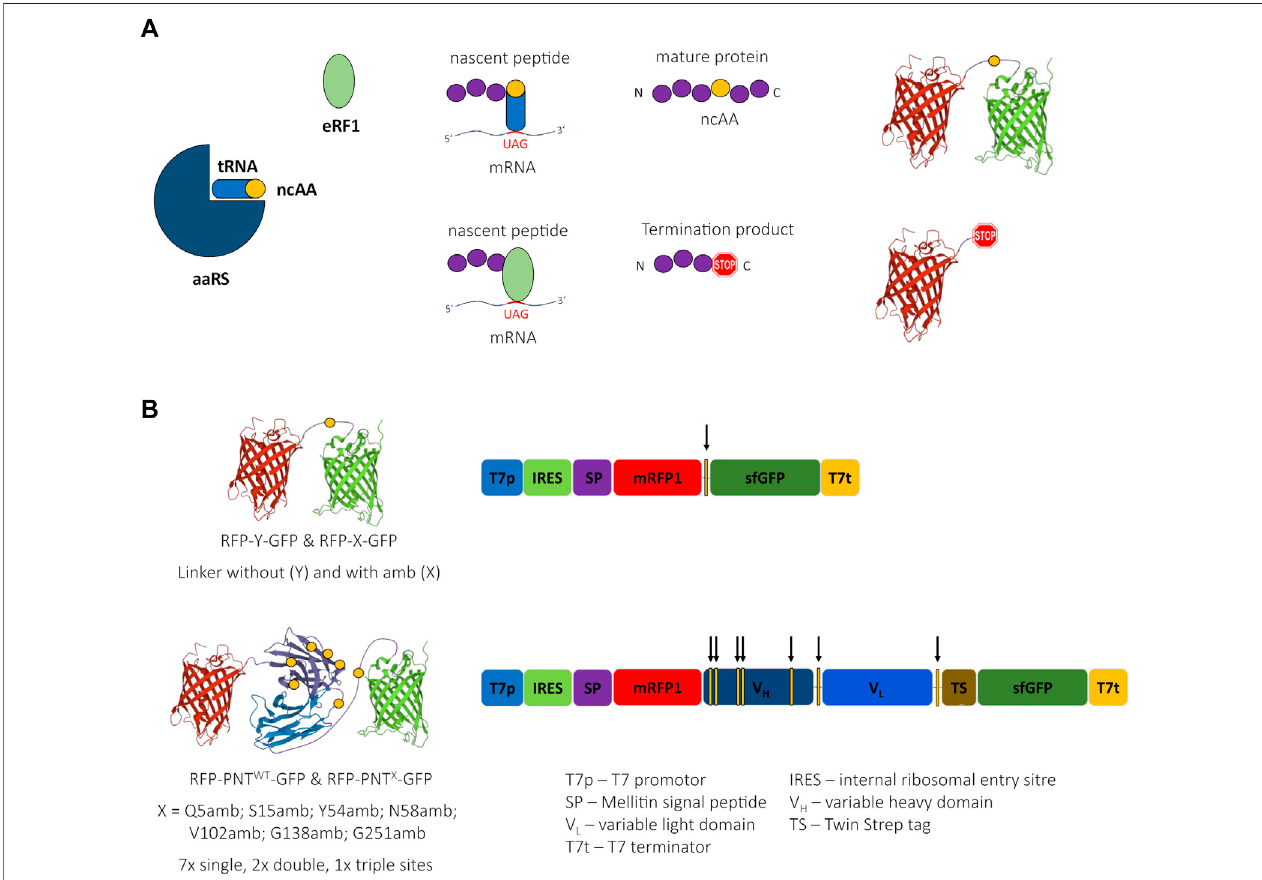
FIGURE 1 | Cartoon of amber suppression, reporter proteins, and ncAA sites. (A) Incorporation of a noncanonical amino acid (ncAA) requires three components: The suppressor tRNA isamino-acylated withthencAAbytheaminoacyltRNA synthetase(aaRS).ThencAA-loaded suppressor tRNA recognizestheUAG(amber) stop codonofthemRNAandtheribosomeincorporatesthencAAintothenascentpeptidechainleadingtoasuppressionproductcontainingancAA.Translationtermination competes with ncAA incorporation due to codon stop recognition by release factor eRF1, causing the generation of a termination product not containing a ncAA. (B) Schematic 3D-structure of the reporter proteins RFP-Y-GFP and RFP-PNT-GFP (left, the yellow circles depict the ncAA incorporation sites) and schematic of respectiveDNAsequences(right,theyellowbarswitharrowsdepictthencAAincorporationsites).3DstructurecartoonsarebasedonPDBstructures2H5Q,5SX4,and 2B3P.